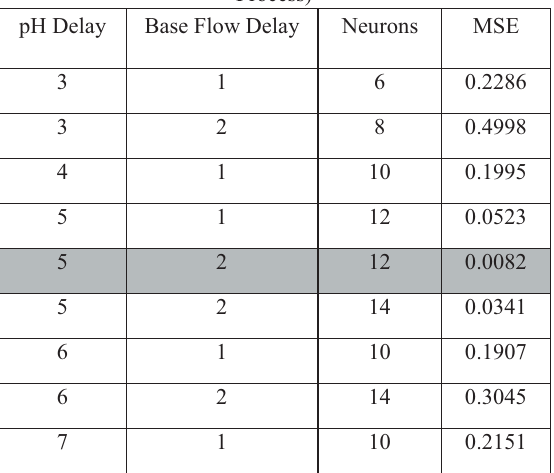
Table 2: Training result with various input-output delays (pH